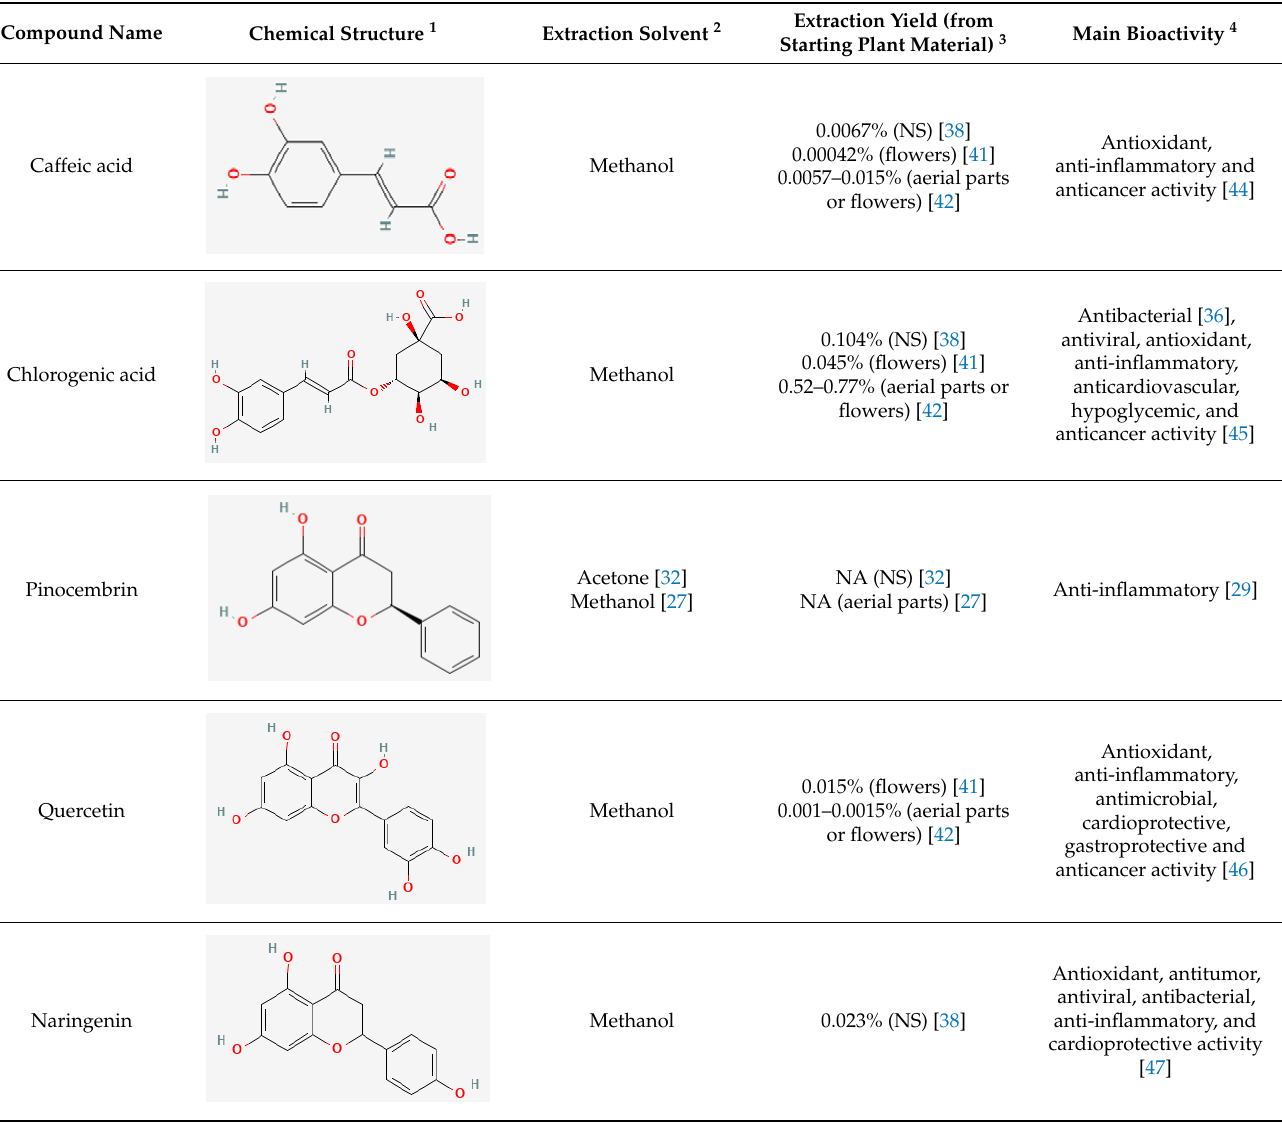
Table 1. The list of the most characteristic bioactive compounds found and investigated in H. italicum .